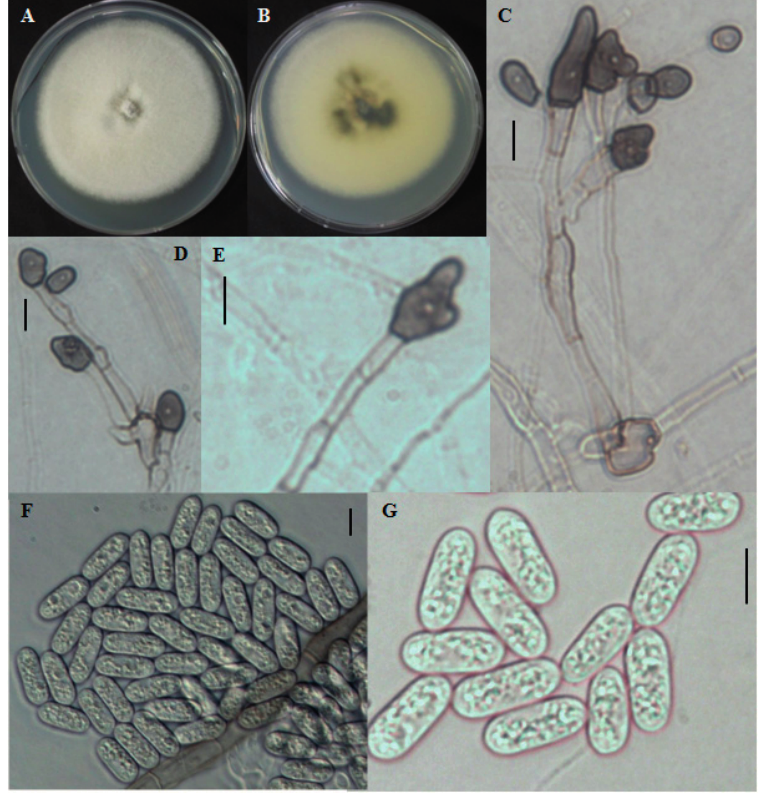
Figure 4. Morphological features of Colletotrichum brevisporum CNU122032. Colony in PDA after 7 days of inoculation at 25 °C ( A , obverse; B , reverse); C – E : appresoria; F , G : Conidia (scale bars C – G = 10 μ